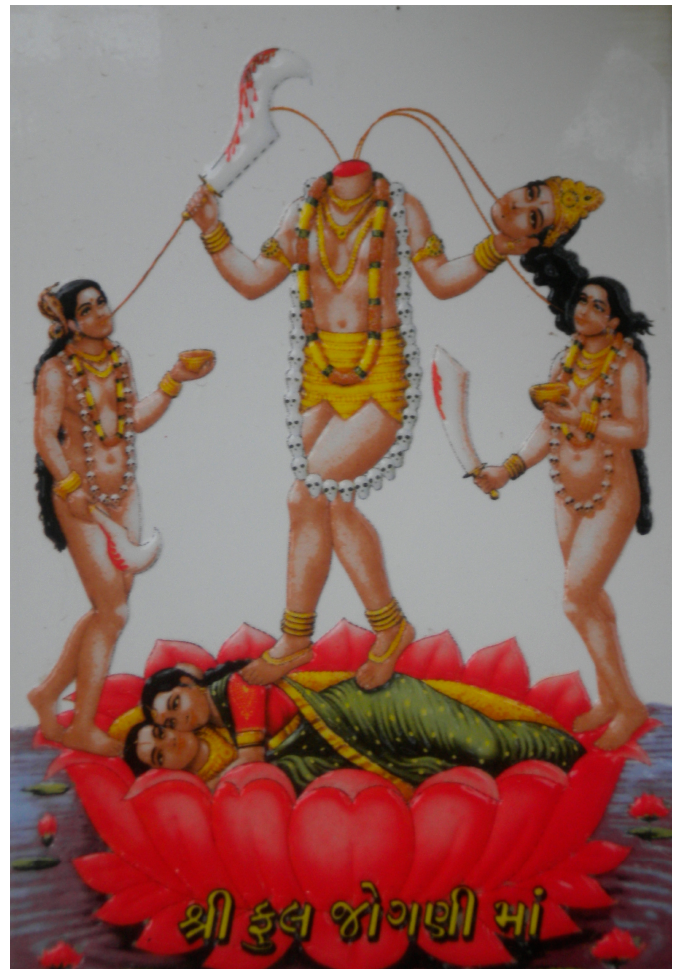
Figure 1 . A common Gujarati representation of Joga ṇ ī M ā t ā , captioned here as “ Ś r ī Ph ū l Joga ṇ ī M ā ”. Figure 1. A common Gujarati representation of Jogan.¯ı M¯at¯a, captioned here as “´Sr¯ı Ph¯ul Jogan.¯ı M¯a”. Photo by author. Photo by